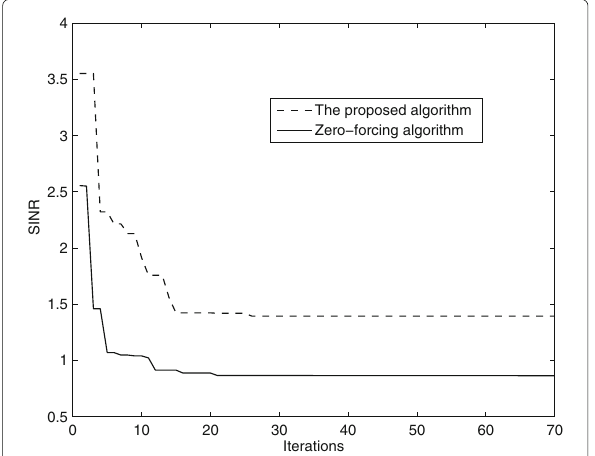
Fig. 4 The variations of SUs’ power versus the number of iterations for variable target